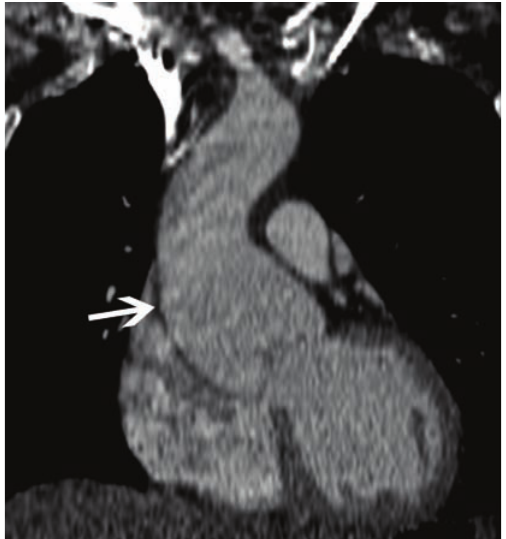
Figure 9: Annuloaortic ectasia—coronal oblique MRI image in a 30-year-old male with Marfan syndrome shows dilated aortic root and ascending aorta with effacement of the sinotubular junction (arrow) consistent with annuloaortic ectasia.